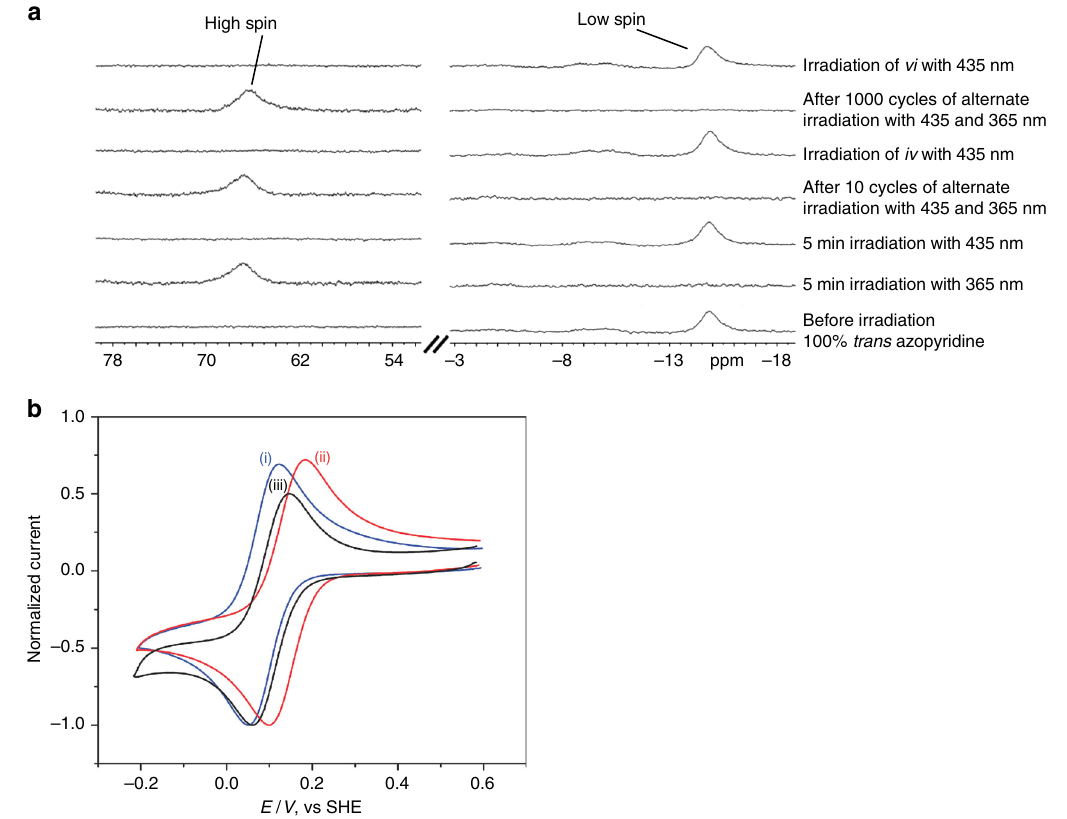
Fig. 6 Switching of the properties of iron porphyrin FeTPP + . a Long-term stability (1000 switching cycles) of a solution of 0.2 mM FeTPPClO 4 , 47.12 mM DMSO- d 6 , and 15 mM azopyridine in acetone- d 6 at 300 K upon irradiation with 365 and 435 nm in an alternating sequence (left) sections of 1 H NMR spectra between 54 and 78 ppm (high-spin region) and (right) between − 18 and − 3 ppm (low-spin region). b Light-induced switching of the redox potential of a solution containing 0.2 mM FeTPPClO 4 , 40 mM tetrabutylammonium perchlorate as the supporting electrolyte and 47.2 mM DMSO in acetone (see Methods, Electrochemical measurements). Blue: cyclic voltammogram before irradiation; red: after irradiating with 365 nm for 20 min; black: after irradiation of the above with 435 nm light for 30 min. The experiment was performed using a platinum disk working electrode, platinum counter electrode, and Ag/AgNO 3 0.01M reference electrode at a scan rate of 50 V/s (see Methods, Electrochemical measurements)